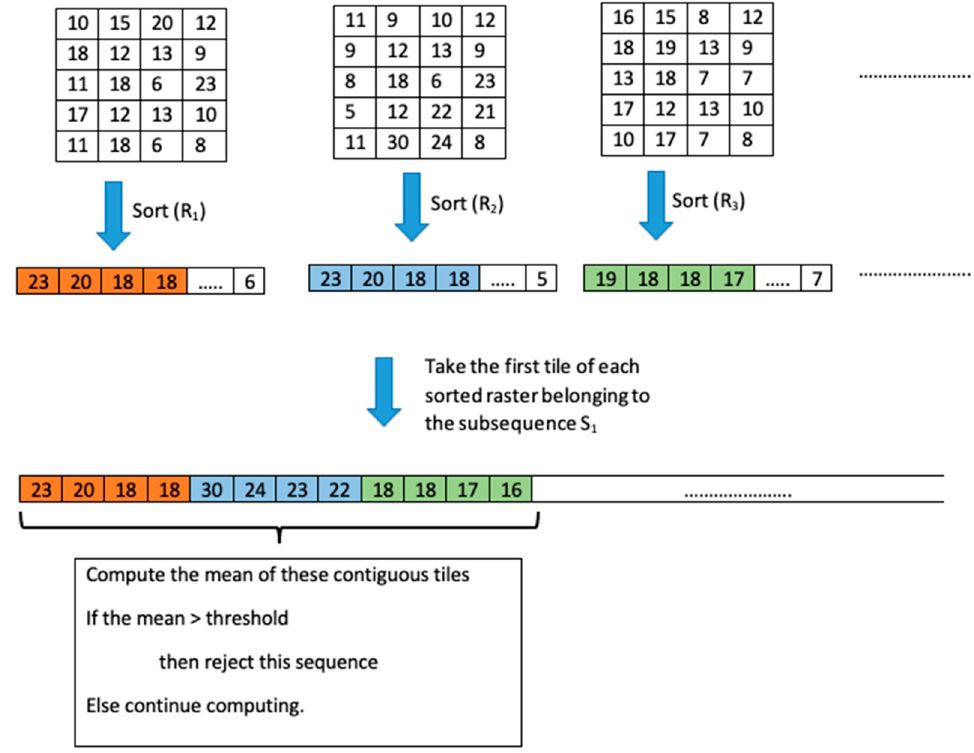
Figure 4. Illustration of our method for the first subsequence S 1